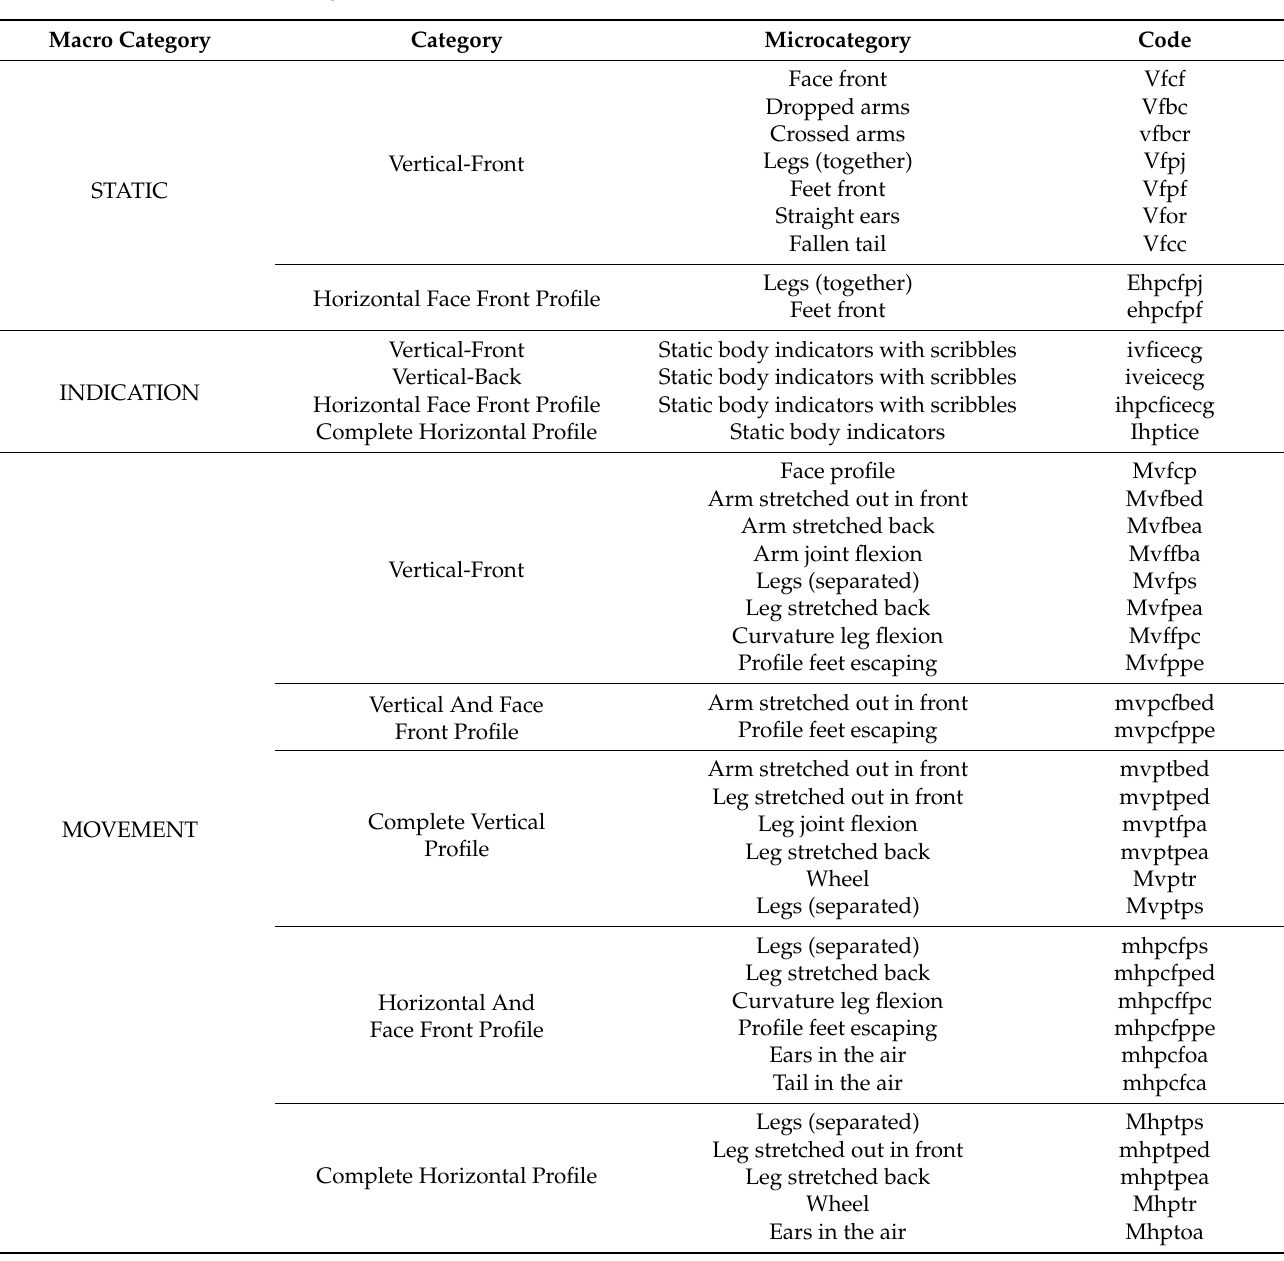
Table 1. Simplified version of the data collection instrument: codes with the highest number of significant